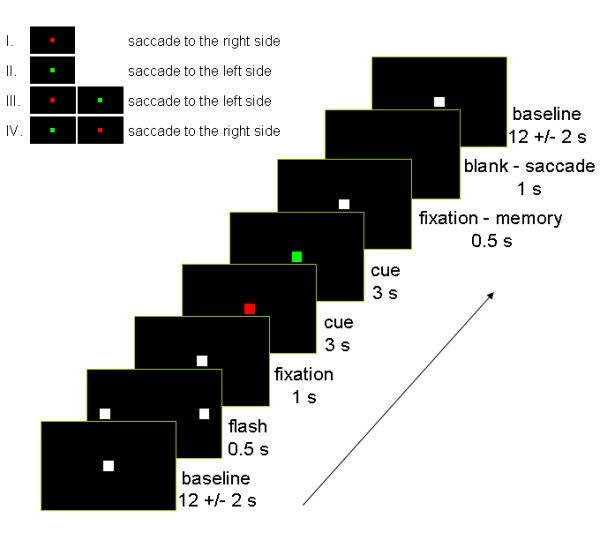
Experimental task design. The cue turned either red signaling a saccade to the right side or green signaling a saccade to the left side. Each target position was given by a previously flashed target. The subjects prepared thus a rightward saccade (I. red cue), a leftward saccade (II. green cue), first a right- then a leftward saccade (III. red-green combination), or first a left- then a rightward saccade (IV. green-red combination). The offset of the fixation target indicated the start of the memory saccade.